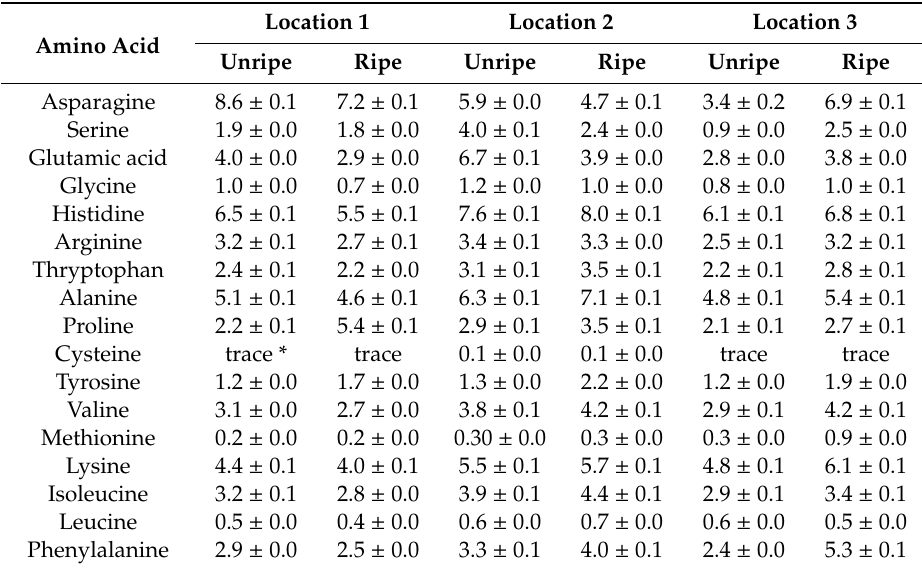
Table 5. Amino acid composition of the protein fraction of J. excelsa unripe and ripe galbuli from the three collection sites in Bulgaria (mean ± SD), mg / g.